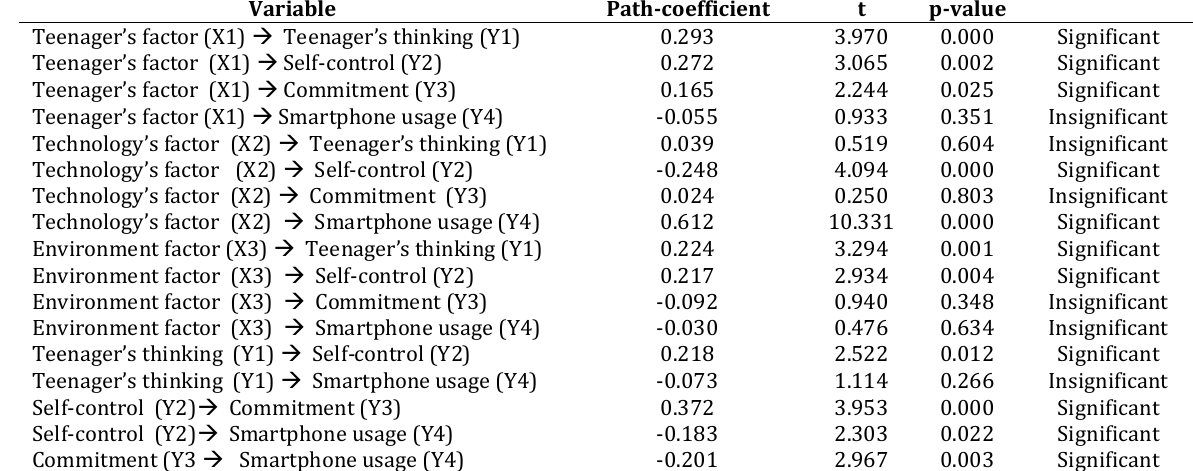
Table 5. Final Model of Hypothesis Test on The Development o f Teenagers’ Safety Smartphone Use